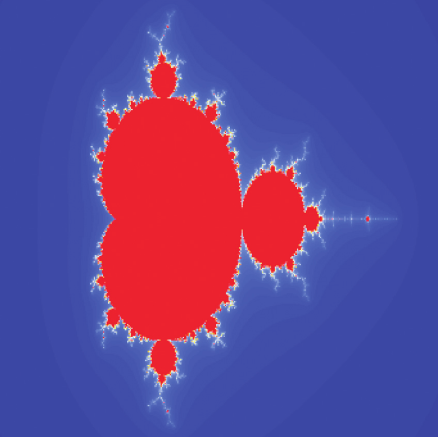
Figure 18: Quadratic Mandelbrot set in JSOmhh.